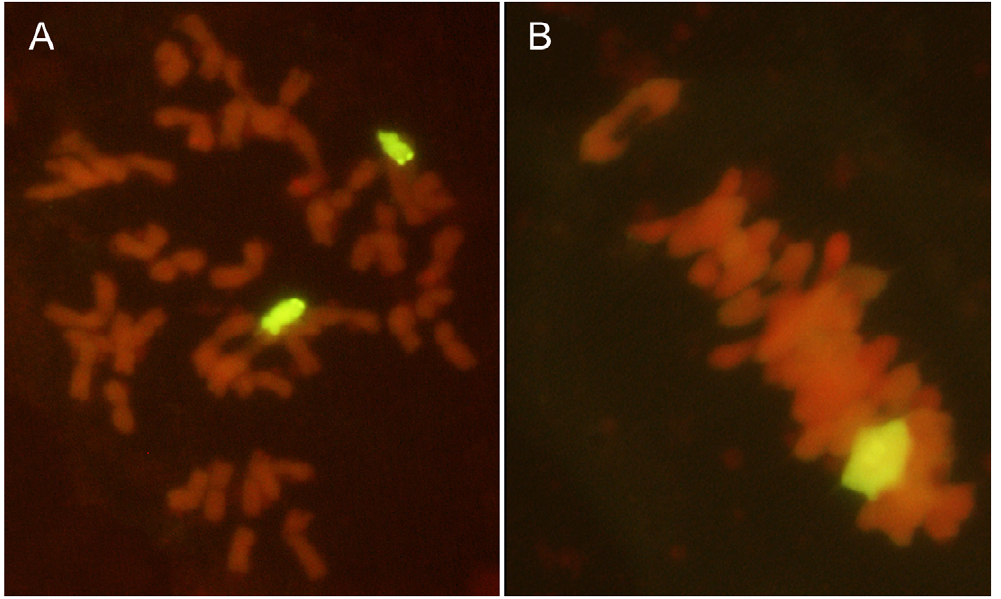
Figure 3. Mitotic and meiotic GISH analysis of the wheat- Psathyrostachyshuashanica addition line 59-11. a Somatic metaphase of the disomic chromosome addition line with two Psathyrostachys huashanica chromosomes (yellowish-green color); b PMCs at meiotic metaphase I, where the yellowish-green color indicates a ring bivalent chromosome from Psathyrostachys huashanica (color figure online).